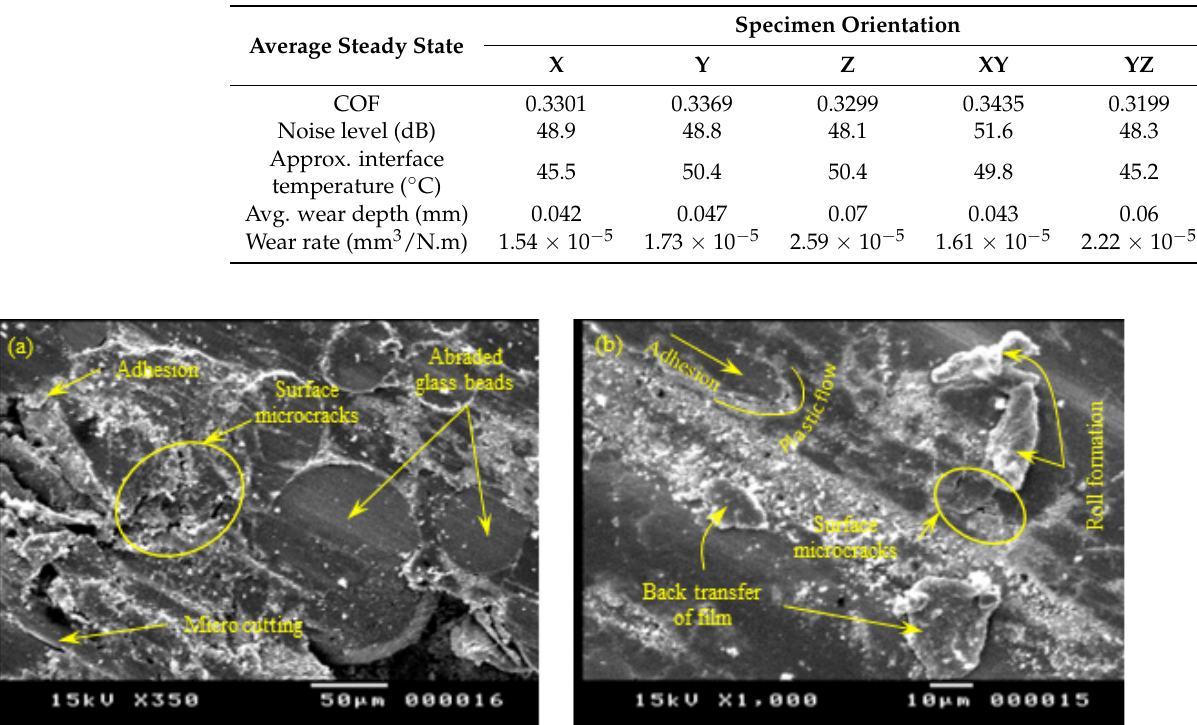
Figure 11. SEM of the tribo-surface for the X-oriented specimen (50 N, 0.25 m/s, and 45 min) at 350 × ( a ) and 1000 × ( b ) magnification.